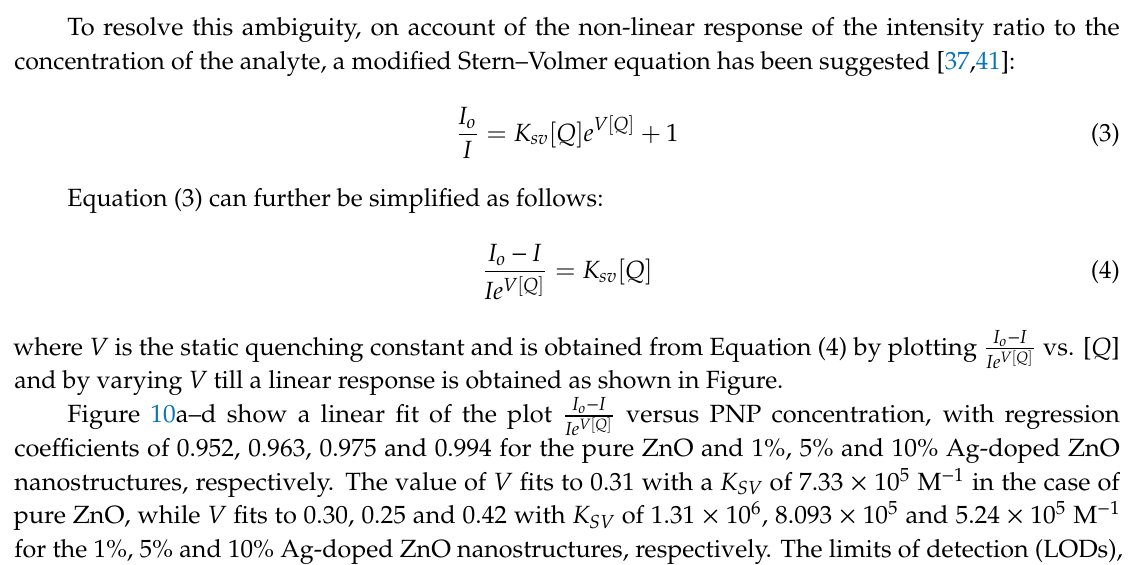
Figure 9. Stern–Volmer plots of Ag x Zn 1-x O nanostructure with increasing concentration of p-nitrophenol.